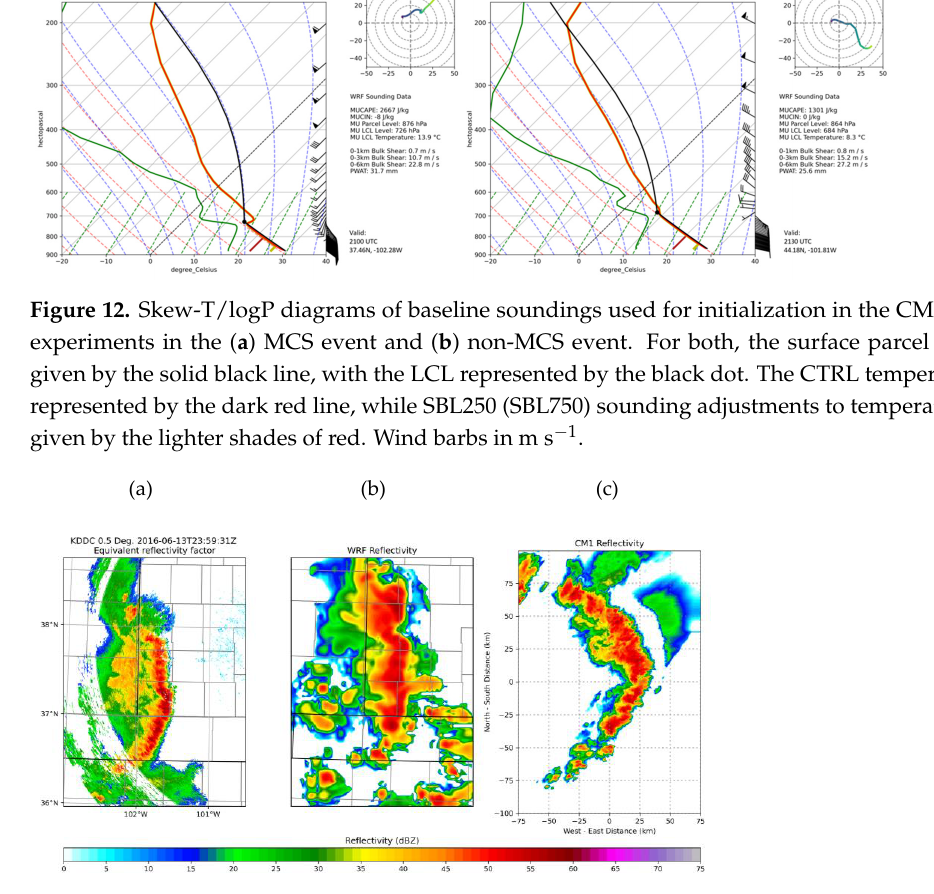
Figure 13. ( a ) Observed base reflectivity at 2359 UTC 13 June 2016 and simulated reflectivity from ( b ) the WRF forecast valid at 0000 UTC 14 June, and ( c ) the CTRL CM1 experiment for the MCS event at 6-h. Distance scales in all three panels are nearly identical. Observational radar data from the NCEI NEXRAD Inventory, plotted through Py-ART [69].